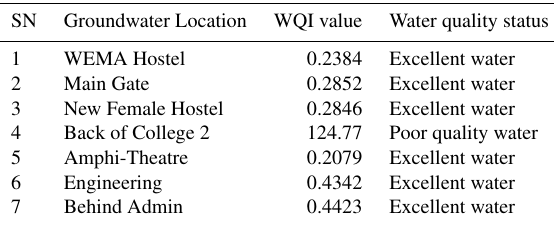
Table 3. Water Quality